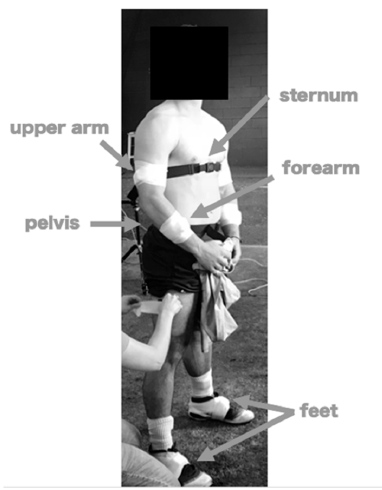
Figure 1. Sensor placement of six inertial sensors (Opal, APDM, Inc., Portland, OR, USA) affixed using straps or adhesive tape.